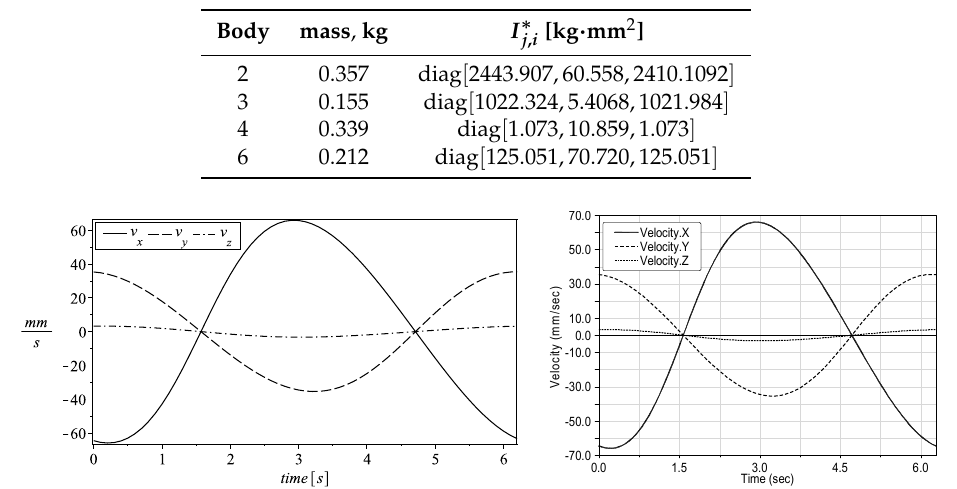
Table 3. Inertial properties of the manipulator’s links.